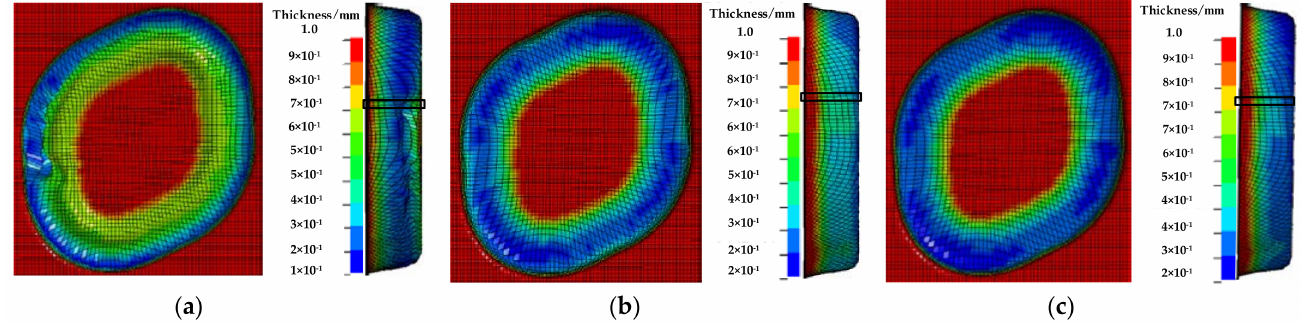
Figure 13. The thickness distribution: ( a ) the traditional multi-stage; ( b ) the proposed method ( ψ = 5 ◦ ); and ( c ) the proposed method ( ψ = 15 ◦